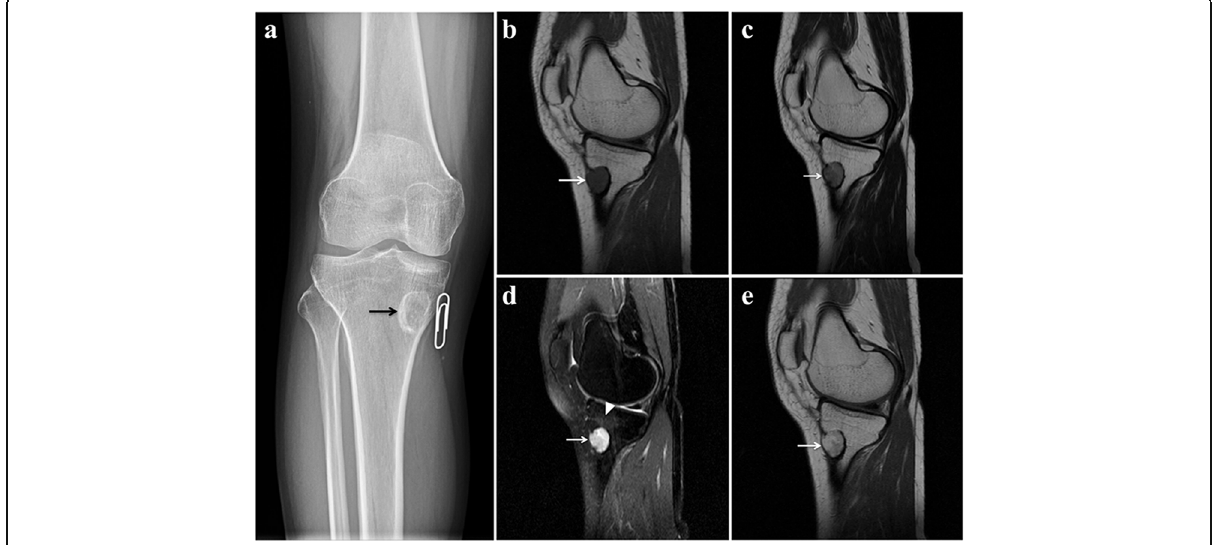
Fig. 1 Radiological features of the lesion. a . A conventional anterior-posterior radiograph revealed an osteolytic lesion located in the medial superior metaphysis of the right tibia. The sclerotic rim (black arrow) indicated non-aggressiveness. b - e . Magnetic resonance imaging demonstrated oval eccentric osteolytic lesions in the right tibial medial condyle. It appeared non-specifically isointense on T1WI ( b ), hyperintense on T2WI, both without ( c ) and with ( d ) fat suppression, and enhanced heterogeneously on contrast-enhanced T1WI ( e ). There was endosteal scalloping and cortical expansion but no cortical disruption, periosteal reaction or soft-tissue mass (white arrow), suggestive of non-aggressiveness. Peritumoural oedema (arrowhead) was noted on T2WI with fat suppression ( d